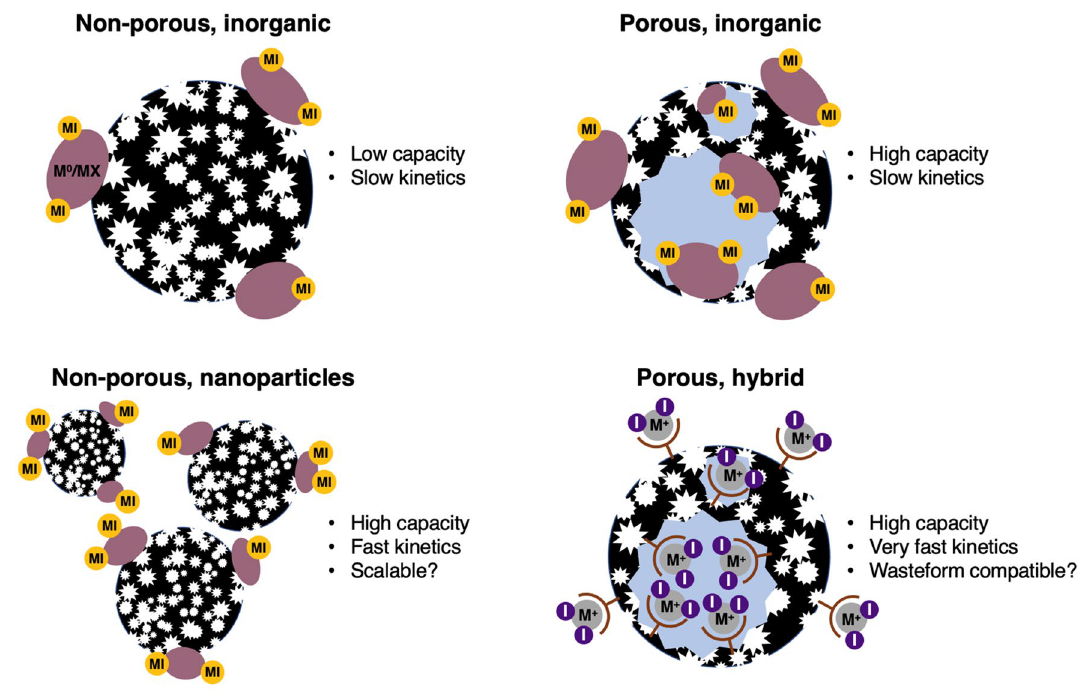
Fig. 5 General attributes of the four classes of adsorbent considered in the